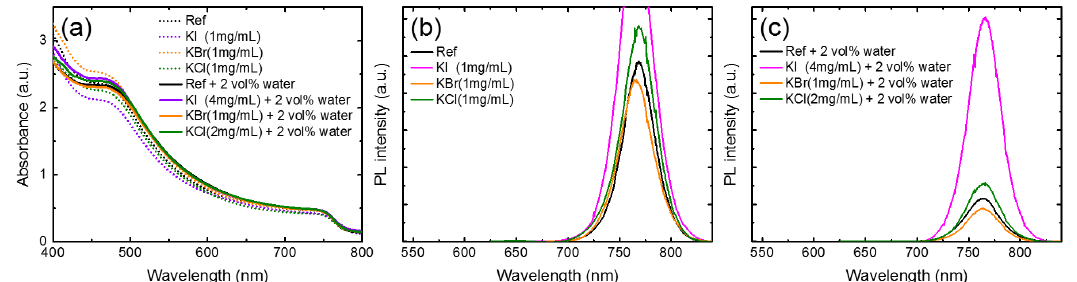
Figure 7. ( a ) Absorption spectra and ( b , c ) photoluminescence (PL) spectra of perovskite films prepared